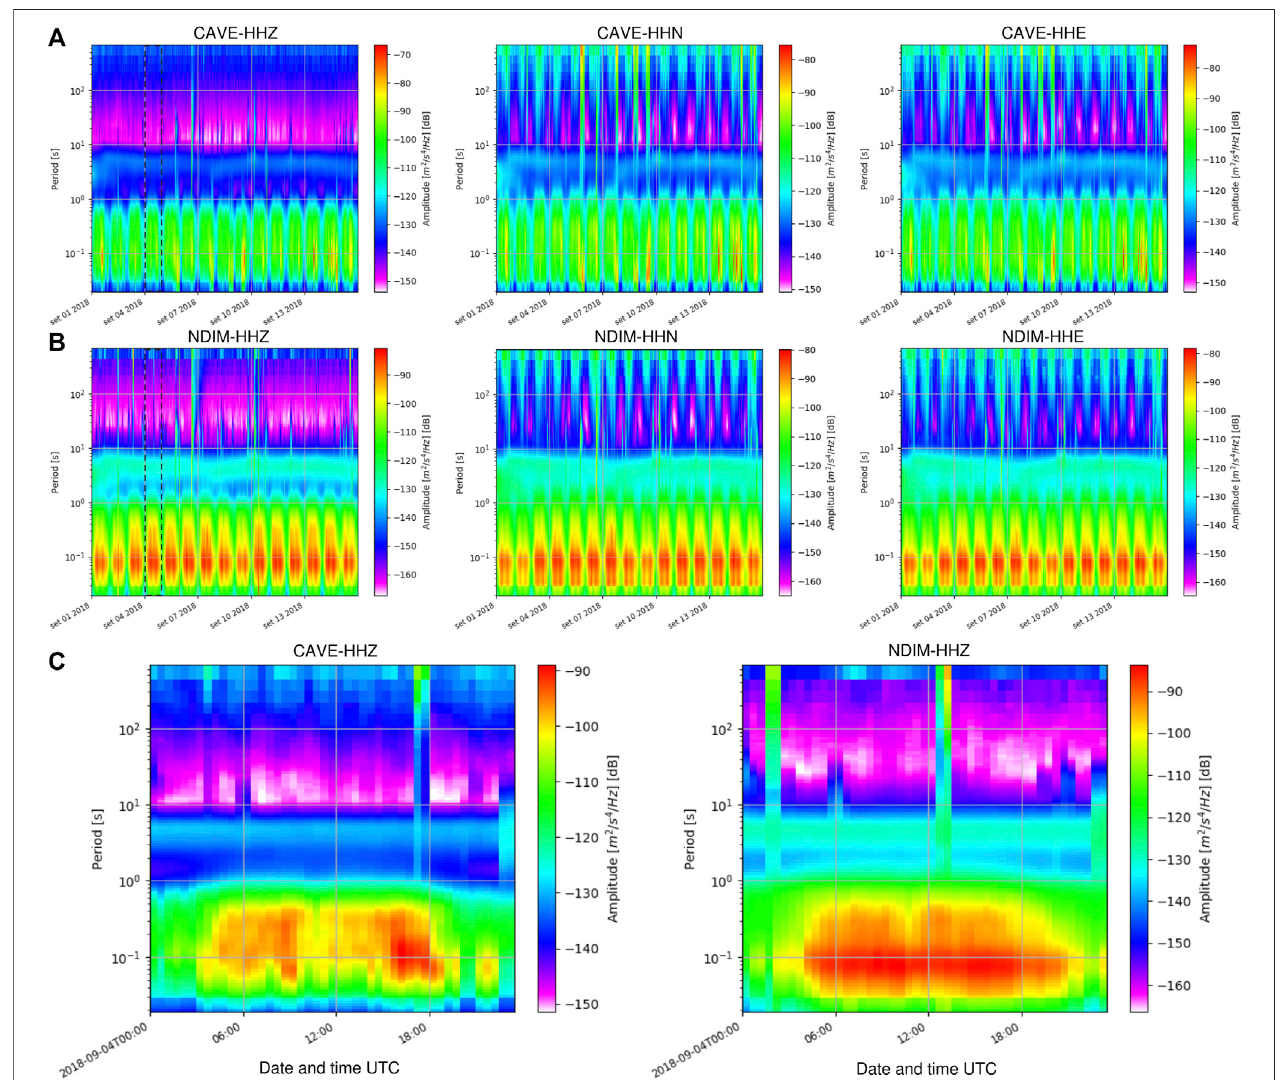
FIGURE3| SpectrogramsforthethreecomponentsofCAVE (A) andNDIM (B) stationsusingthedataacquiredfrom1to15September,2018.In (C) isazoomon the day of 4 September for both stations vertical components, to emphasise the daytime increase in seismic noise levels at periods less than 1 s. The selected day is indicated by the dashed vertical lines in the HHZ spectrograms of panels (A) and (B) . The color scale represents the PSD value in dB with respect to 1 m/s and is optimised for each sub- fi gure.